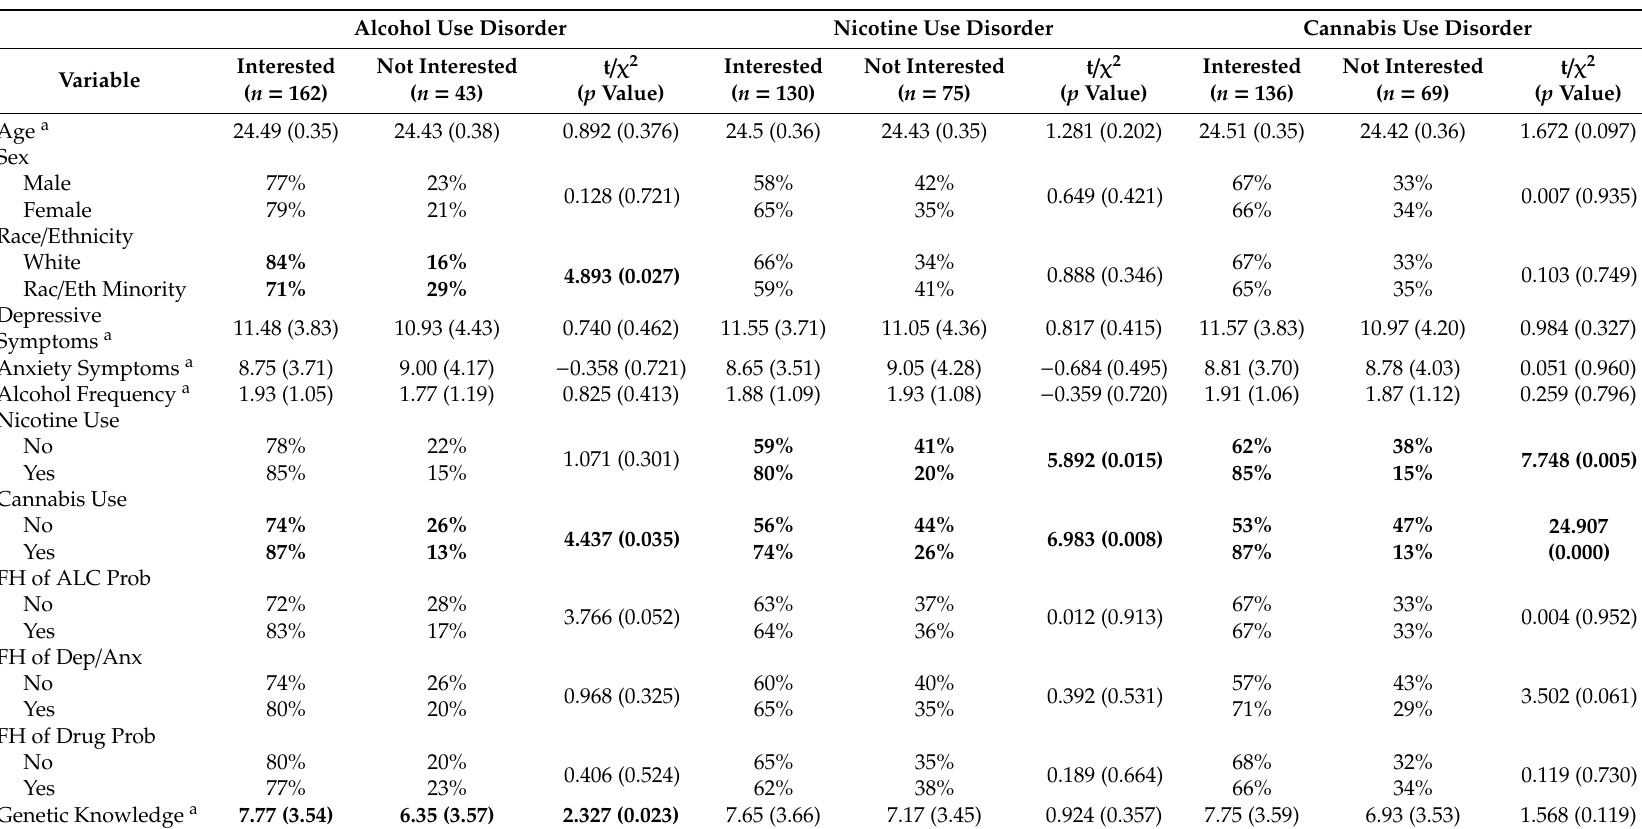
Table 4. Results of the chi-square and t -tests to compare demographic characteristics, substance use and mental health variables, family history, and overall genetic knowledge between those interested in receiving feedback for alcohol use disorder, nicotine use disorder, and cannabis use disorder and those not